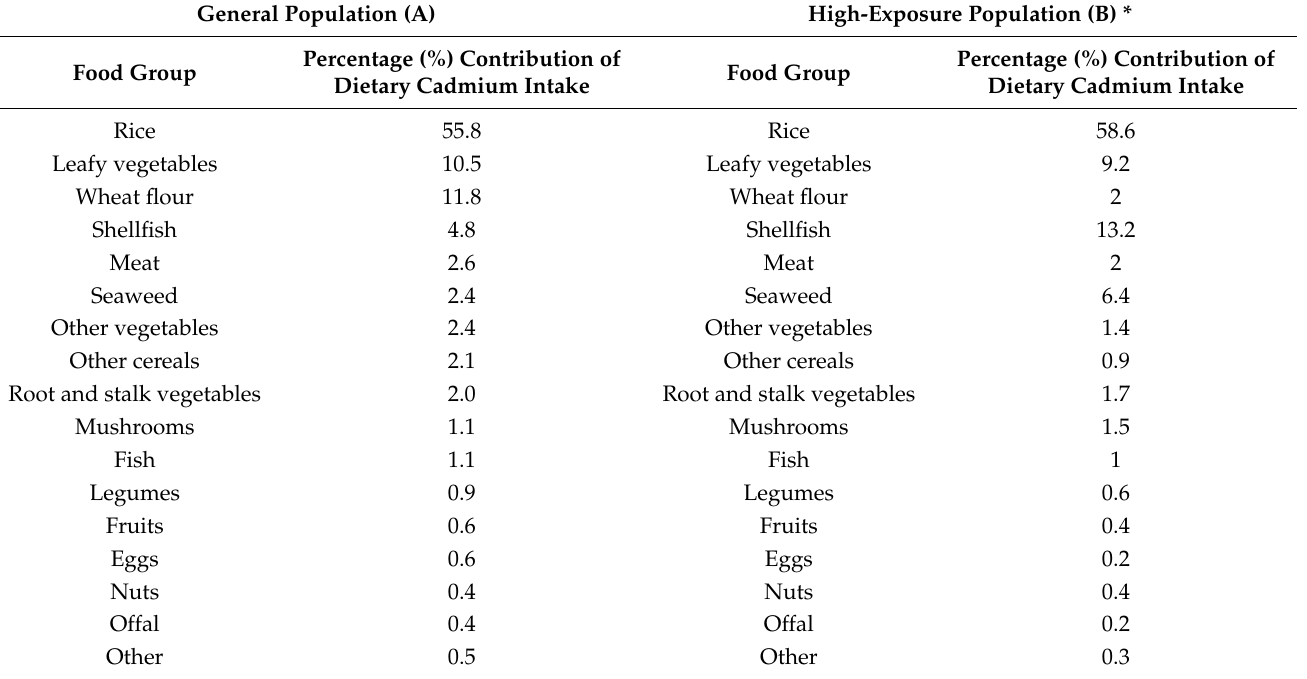
Table 2. Data depicting the main contributors to dietary cadmium intake in (A) the general Chinese population and (B) the highly exposed Chinese population. Data adapted with permission from